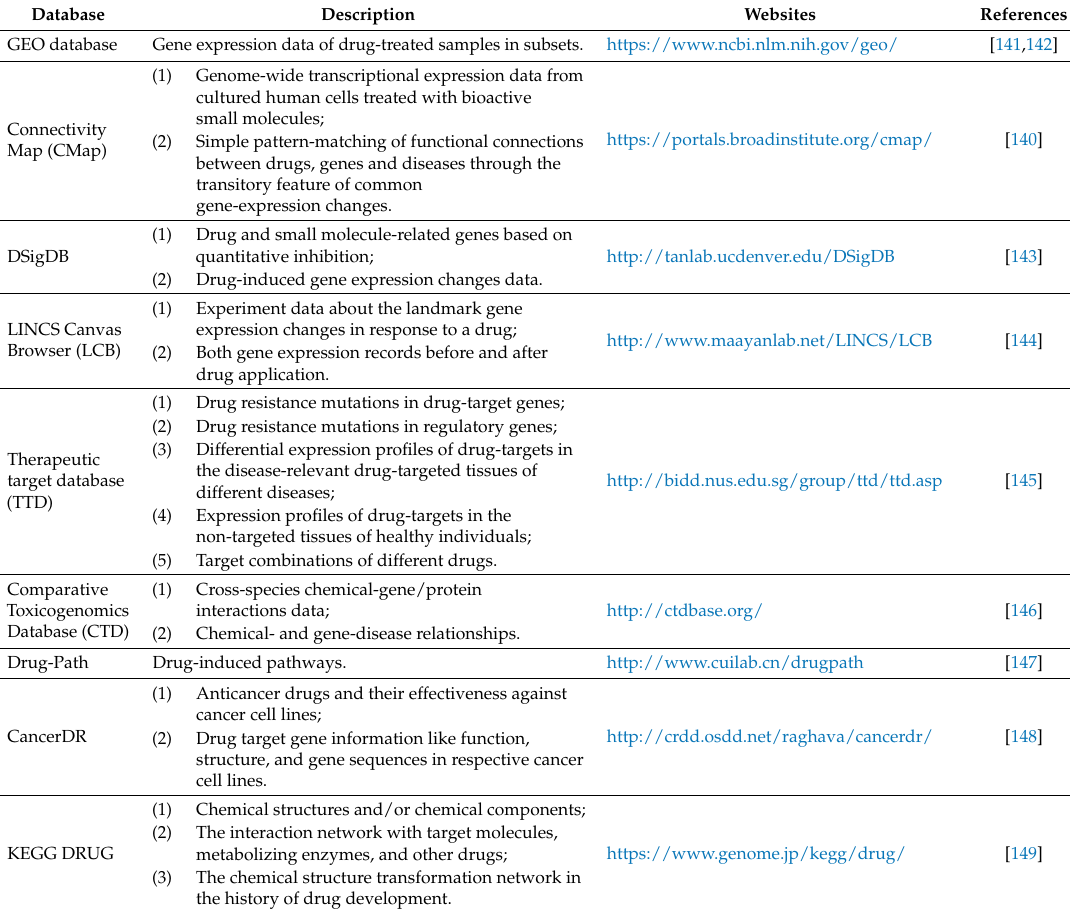
Table 4. Databases of drug induced gene expression.